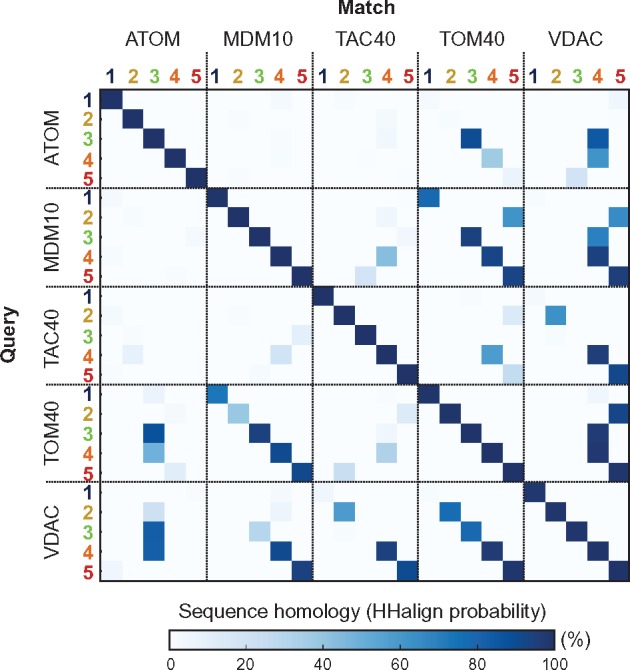
—Sequence homology matrix of double ββ-hairpins from MOMBBs, measured as the hhalign probability of the alignment of their HMM-profiles built with hhmake. For clarity, only the top match of a given query double ββ-hairpin in each of the MOMBB subfamilies is shown. Almost invariably, significant matches for repeat n of one MOMBB has its best match in repeat n′ of another MOMBB, suggesting that all 19-stranded MOMBBs diverged from a fully amplified ancestor and were not amplified individually.